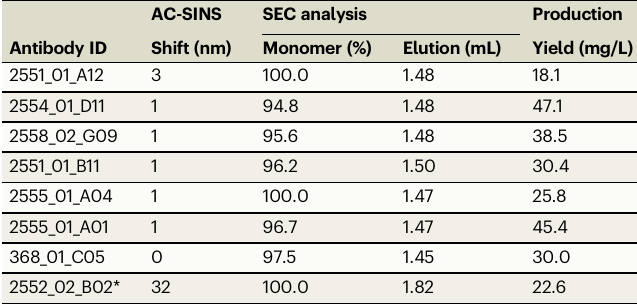
Table 1 | AC-SINS shift, SEC analysis results (% monomer content and relative elution volume), and transient expres- sion yields for the top six light chain-shuf fl ed